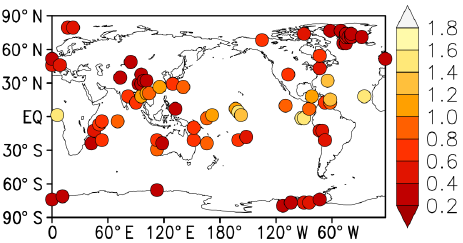
Figure 8. Signal-to-noise ratio (SNR) of the reconstructed temper- ature from the observation used in